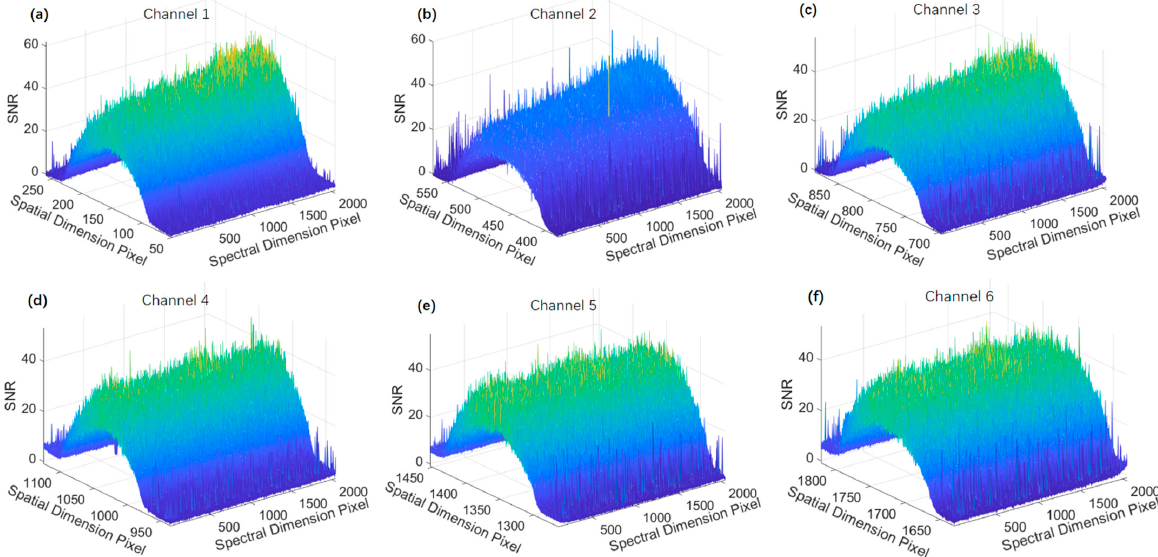
Figure 21. SNR of a single pixel ( a ) Channel 1; ( b ) Channel 2; ( c ) Channel 3; ( d ) Channel 4; ( e ) Channel 5; ( f ) Channel 6.